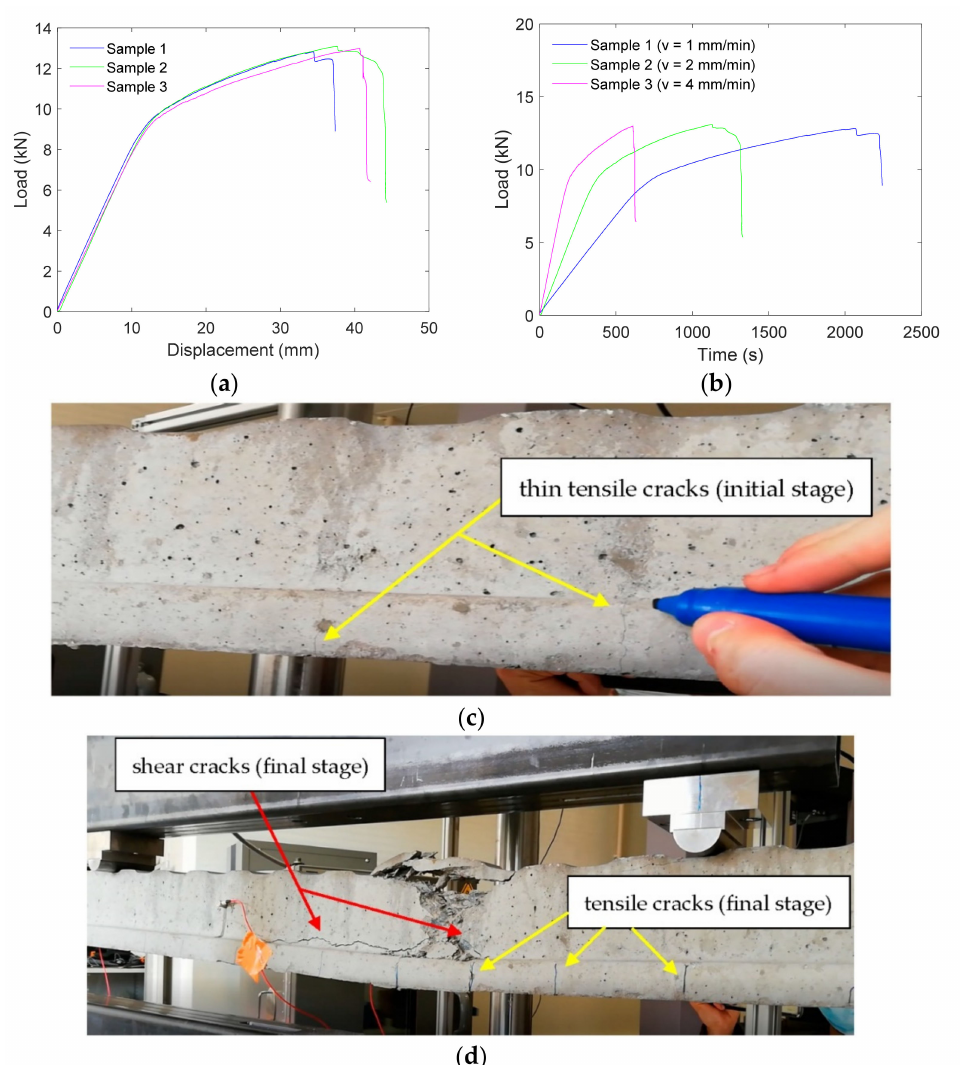
Figure 7. ( a ) Evolution of load as a function of displacement, ( b ) evolution of load as a function time, ( c ) initial cracks, and ( d ) rupture of the